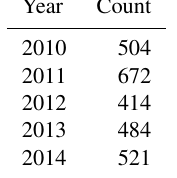
Figure 18. As for Fig. 9 but for 1904–1919. The location authors of the map in (a) are outlined in Fig. 12. Table 5. As for Table 3 but for 1904–1919. Included in the D flag are 183 events for which no magnitude was recomputed. Quality Count for flag